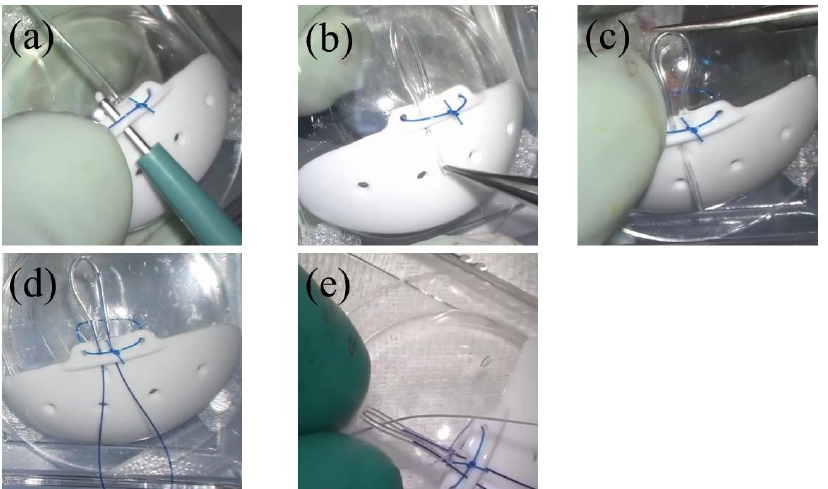
Figure 1. Preparation of the Baerveldt glaucoma implant; ( a ) a parallel tunnel in the plate adjacent to the tube using a 1.0 mm biopsy trephine; ( b ) the tip of the tube was inserted into the tunnel to create a U-shaped loop; ( c ) the outer wall of the tip of the loop was cut with scissors; ( d ) a 3-0 nylon was inserted into both tubes as a stent suture; ( e ) each root of the tube was fastened using 6-0 absorbable sutures. A 4-0 silk thread was then passed through the tube loop.